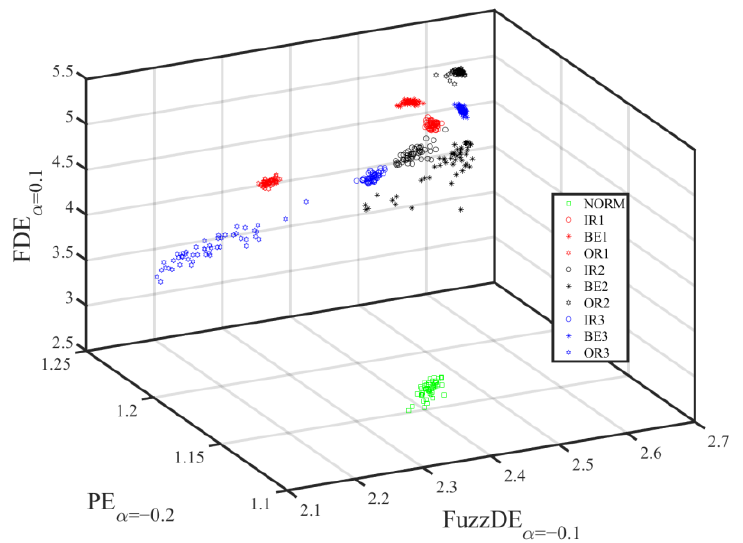
Figure 12. Distribution of the mixed triple features at 100% recognition rate ( FuzzDE α = −0.1 , PE α = −0.2 , FDE α = 0.1 ).